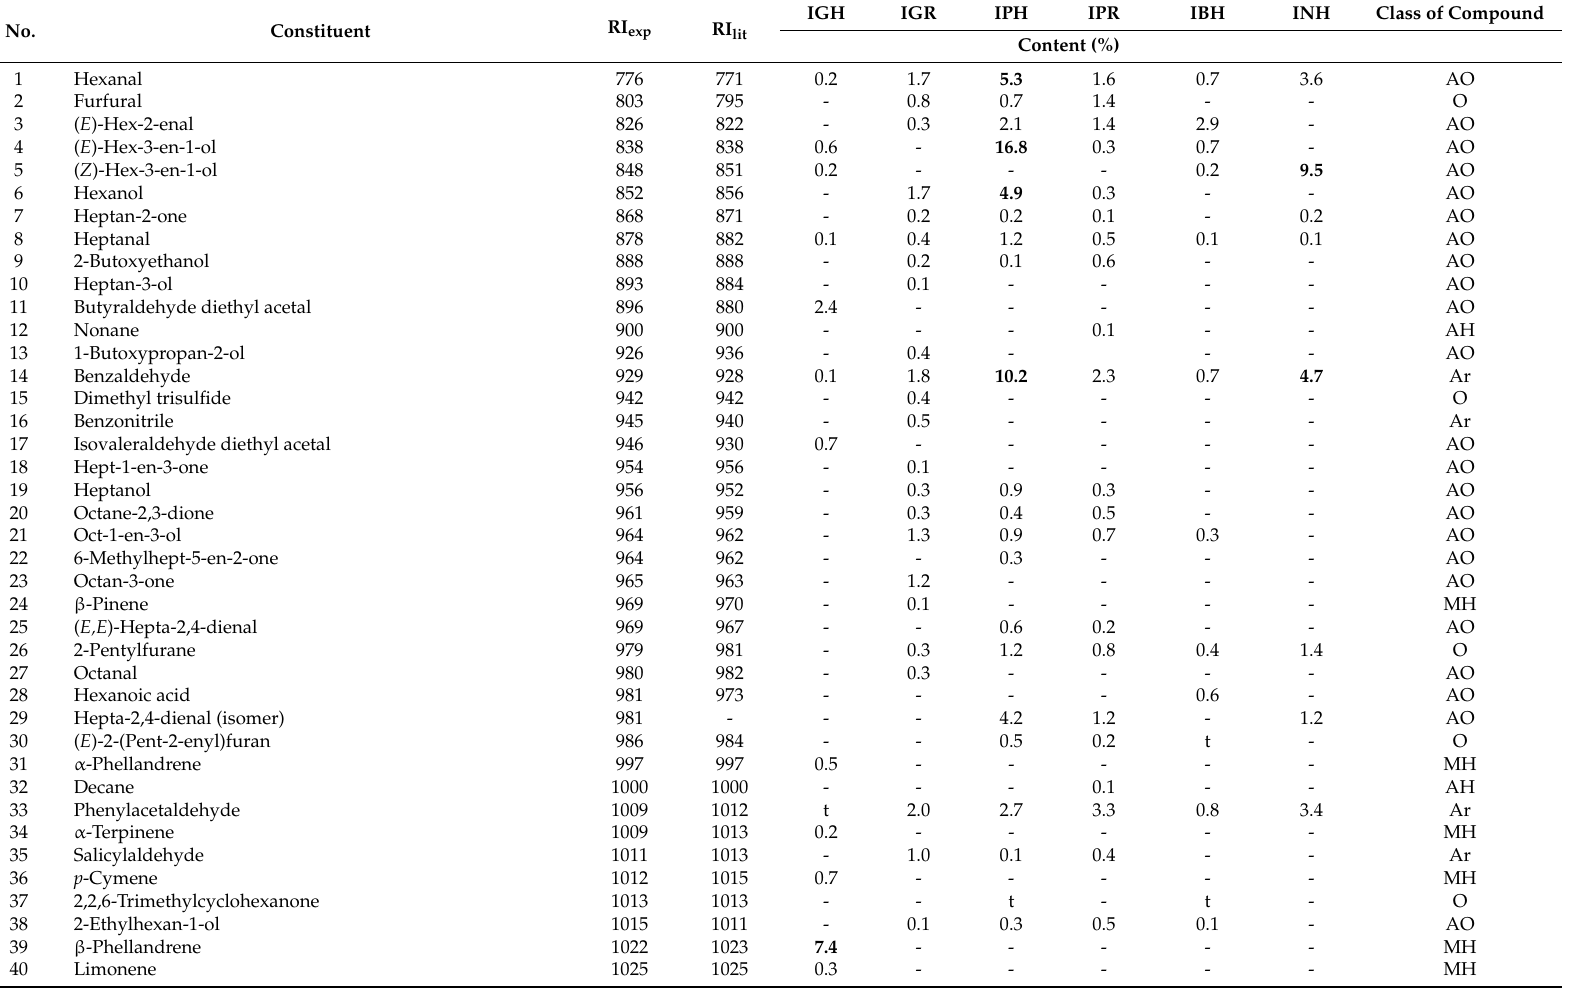
Table 1. Composition of the essential oils of four Impatiens species. IGH, I. glandulifera herb; IGR, I. glandulifera roots; IPH, I. parviflora herb; IPR, I. parviflora roots; IBH, I. balsamina herb; INH, I. noli-tangere herb; RI exp , experimental retention index; RI lit , literature retention index; t, trace (percentage value less than